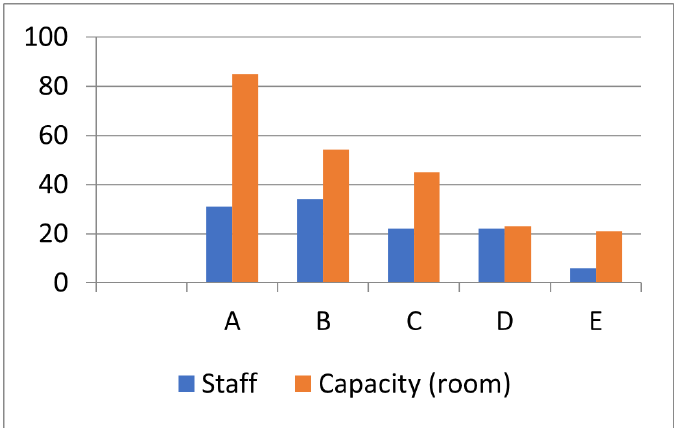
Figure 3: Four hotels (A, B, C, D) and one guest house (E) in Veszpr´em